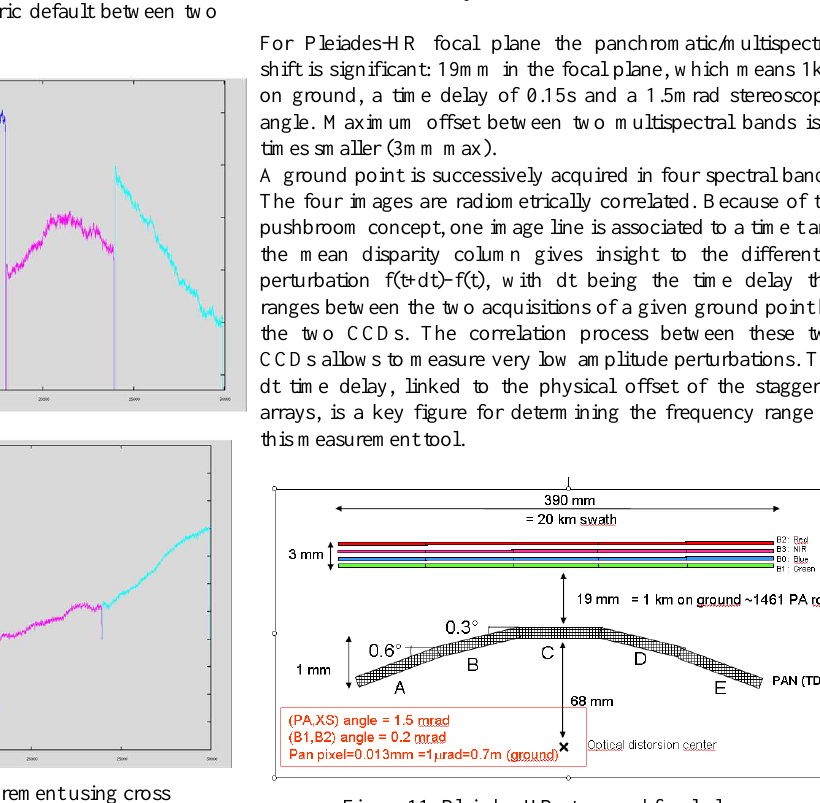
Figure 10: viewing directions measurement using cross acquisition (red) and supersite (blue). The cross acquisition is less noisy than the classical method.